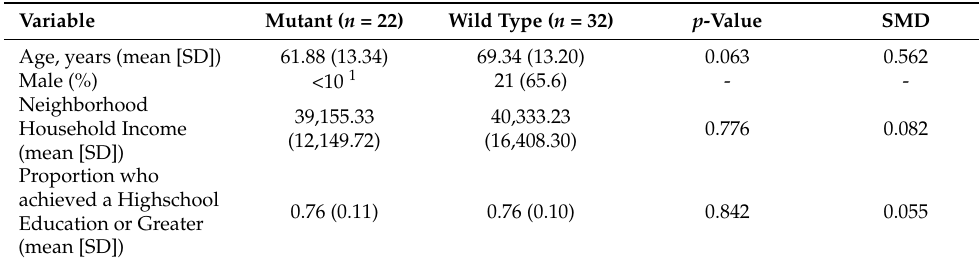
Table 2. Baseline and demographic characteristics of metastatic melanoma patients by BRAF status in Alberta, Canada (diagnosed between